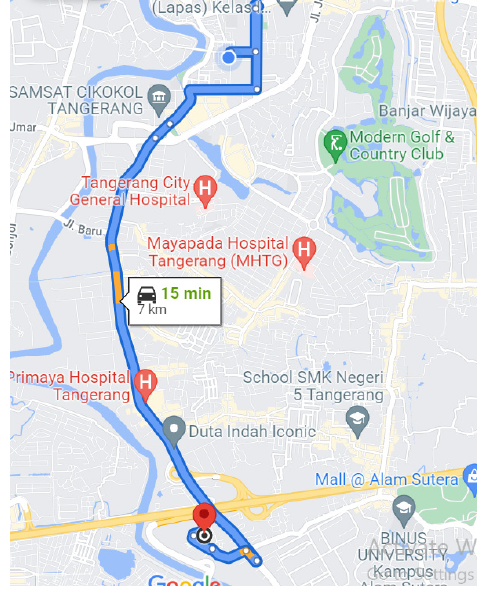
Figure 10. Test path [49].